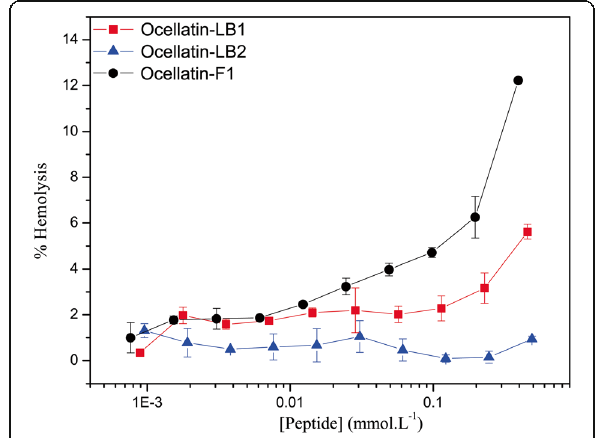
Fig. 3 Hemolytic activities of ocellatin-LB1 ( red squares ), -LB2 ( blue triangles ) and -F1 ( black circles ). Rabbit erythrocytes suspended in phosphate-buffered saline were incubated for 1 h with increasing peptide concentrations up to 1000 μ g.mL −